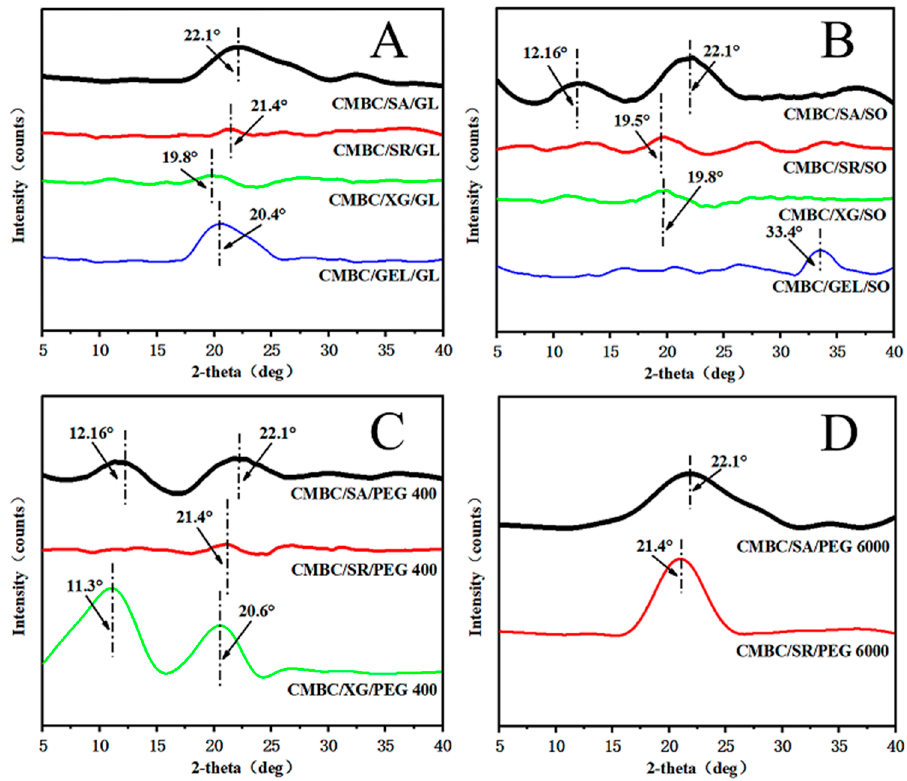
Figure 4. XRD patterns of the composite films ( A ) : CMBC/SA/G, CMBC/SR/Gl, CMBC/XG/Gl & CMBC/GEL/Gl; ( B ) : CMBC/SA/SO, CMBC/SR/SO, CMBC/XG/SO & CMBC/GEL/SO; ( C ) : CMBC/SA/PEG 400, CMBC/SR/PEG 400 & CMBC/XG/PEG 400; ( D ) : CMBC/SA/PEG 6000 & CMBC/SR/PEG 6000).